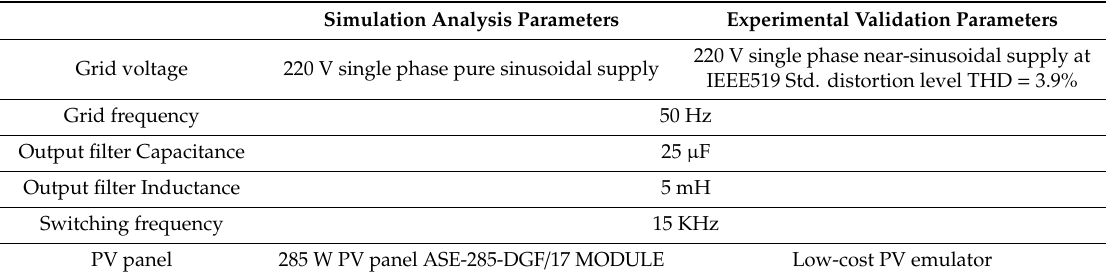
Table A2. System parameters used in simulation analysis and experimental